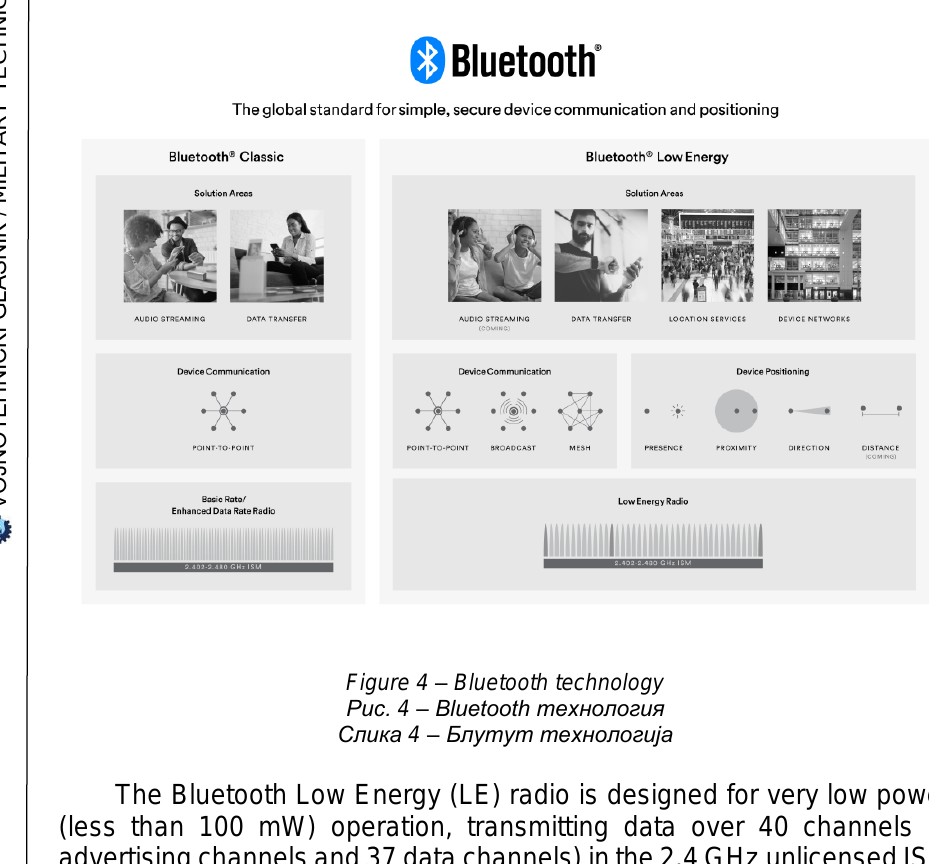
Figure 4 – Bluetooth technology Рис. 4 – Bluetooth технология Слика 4 – Блутут